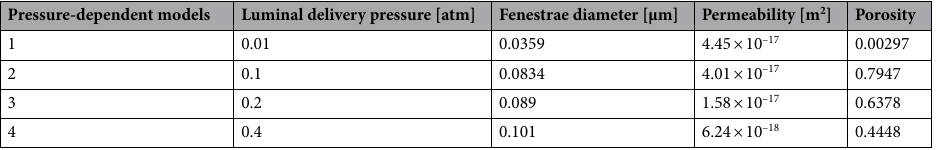
Table 1. Summary of pressure-dependent geometric and material